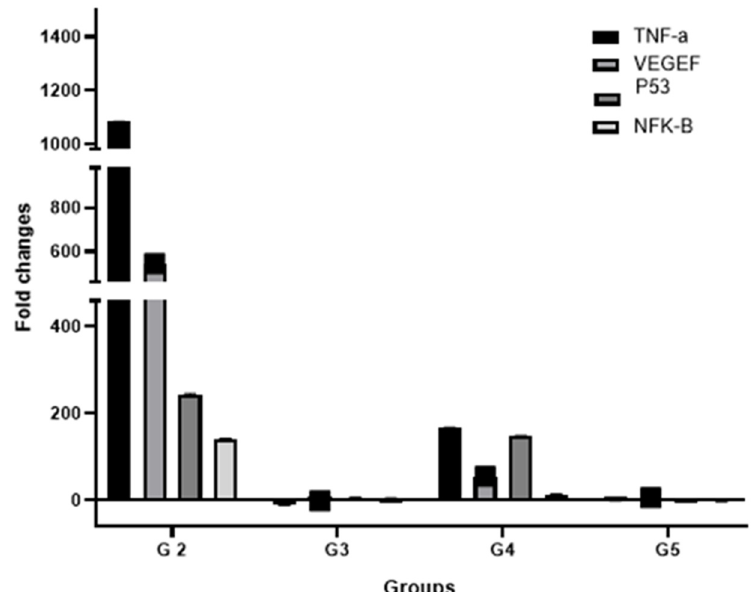
Figure 8. Diagram represents the effect of different drugs on the fold change of gene expression for TNF-a, VEGF, p53 and NF κ B as target genes vs GAPDH as reference gene. The fold change corresponds to the relative expression quantification (RQ) if RQ > 1 (upregulation), − 1/RQ if RQ < 1 (downregulation) and 0 if RQ = 1 (no regulation).